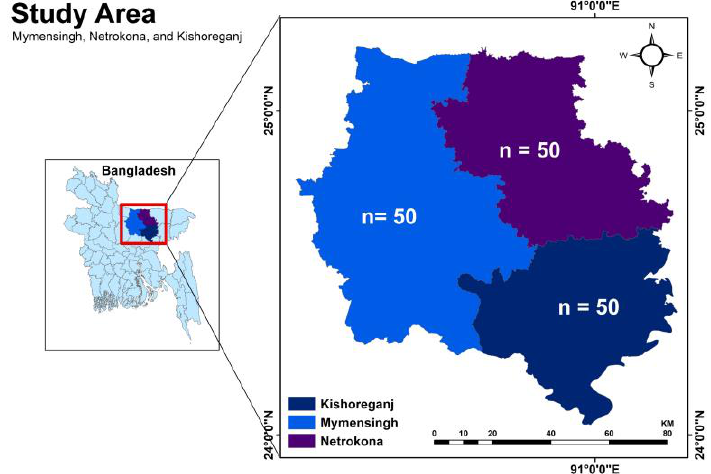
Figure 3. Maps showing study areas in Bangladesh with the number of samples collected from each